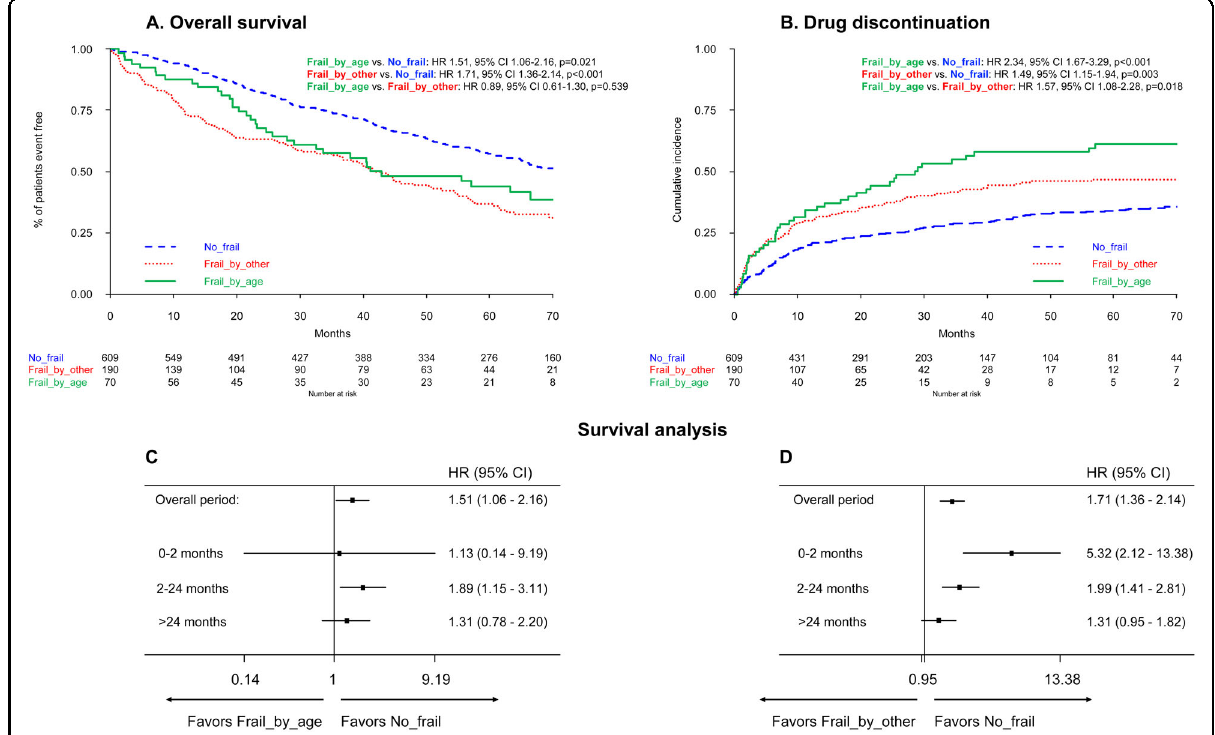
Fig. 1 Outcomes of patients according to frailty group. Overall survival ( A ), cumulative incidence of drug discontinuation for any cause excluding progression and death ( B ), and survival analysis by time from diagnosis ( C , D ). OS overall survival, HR hazard ratio, CI con fi dence interval, p p